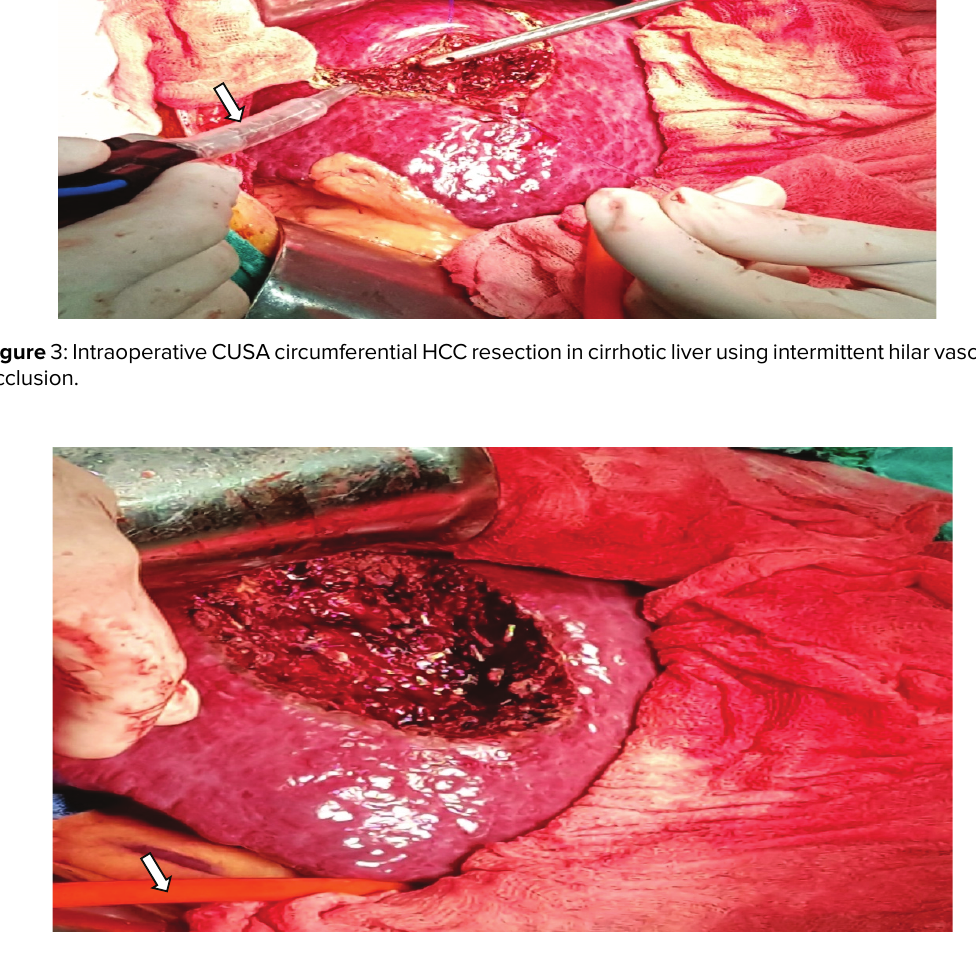
Figure 4: Adequate HCC resection margins within the cirrhotic liver using intermittent hilar vascular